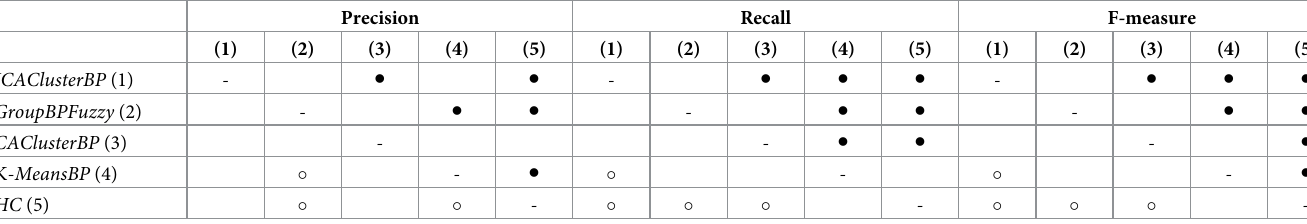
Table 6. Results of Wilcoxon